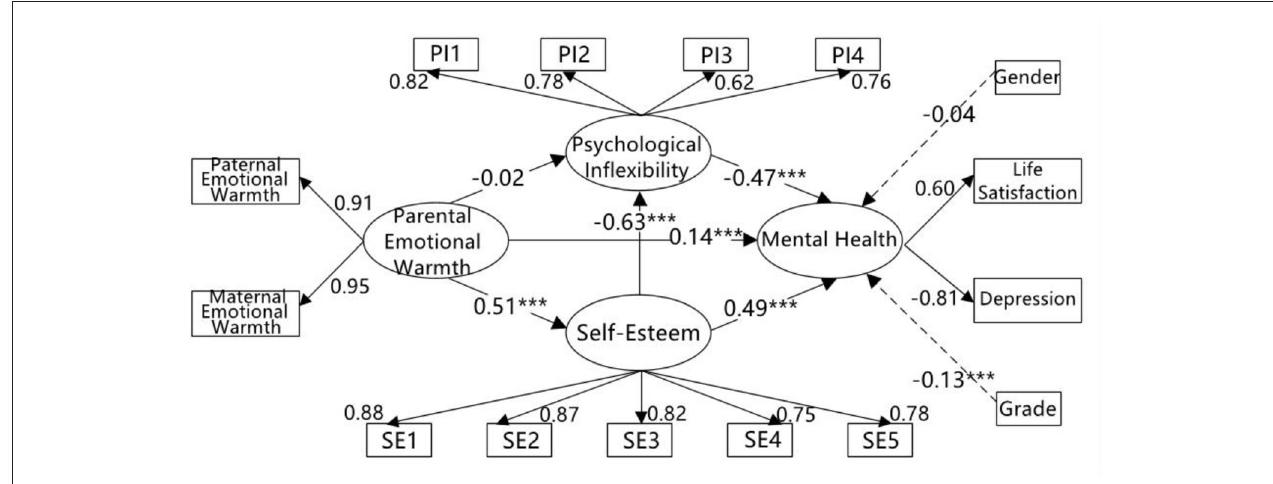
FIGURE 1 | The mediating roles of self-esteem and psychological inflexibility between parental emotional warmth and mental health. PI1–PI4, four parcels of psychological inflexibility; SE1–SE5, five parcels of self-esteem; *** p < 0.001.